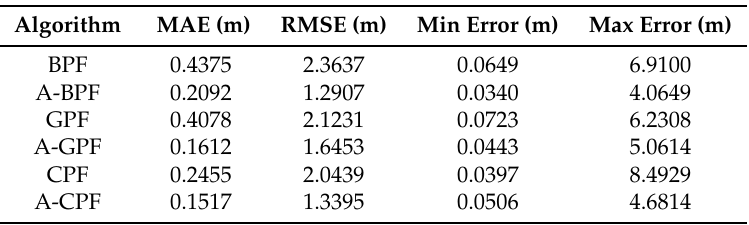
Table 1. Trajectory I: Performance comparison. BPF, bootstrap particle filter; A-BPF, adaptive BPF; GPF, Gaussian particle filter; CPF, constraint particle